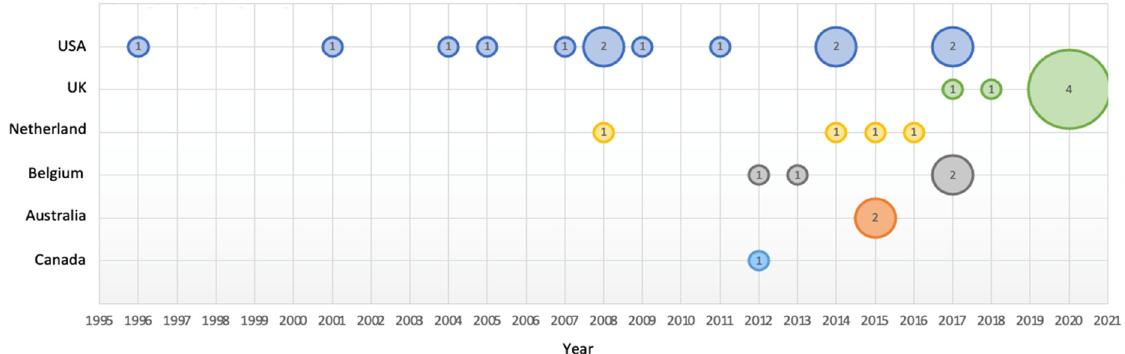
Figure 2. Publication years and countries of included articles ( n = 30). Countries are represented by different colour. The bubble size is proportional to the number of articles published in the year and the country.